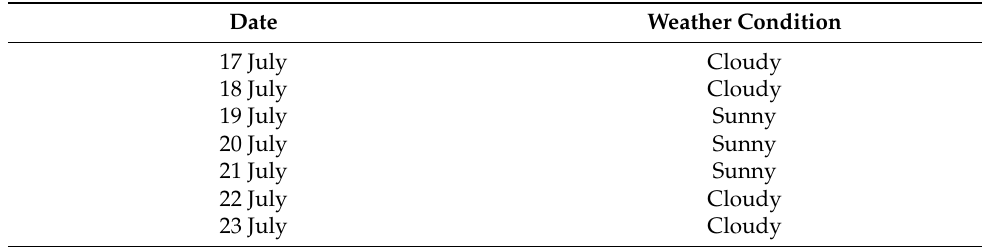
Table 1. Weather conditions of the study area in the study